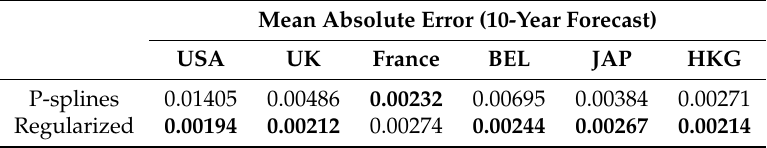
Table 4. Mean Absolute Error for USA, UK, France, Belgium (BEL), Japan (JAP) and Hong Kong (HKG) for the P-spline model in Currie et al. (2004) and our regularized model, based on historical data from 1986 to 2007. In bold: Lowest MAE per Country.